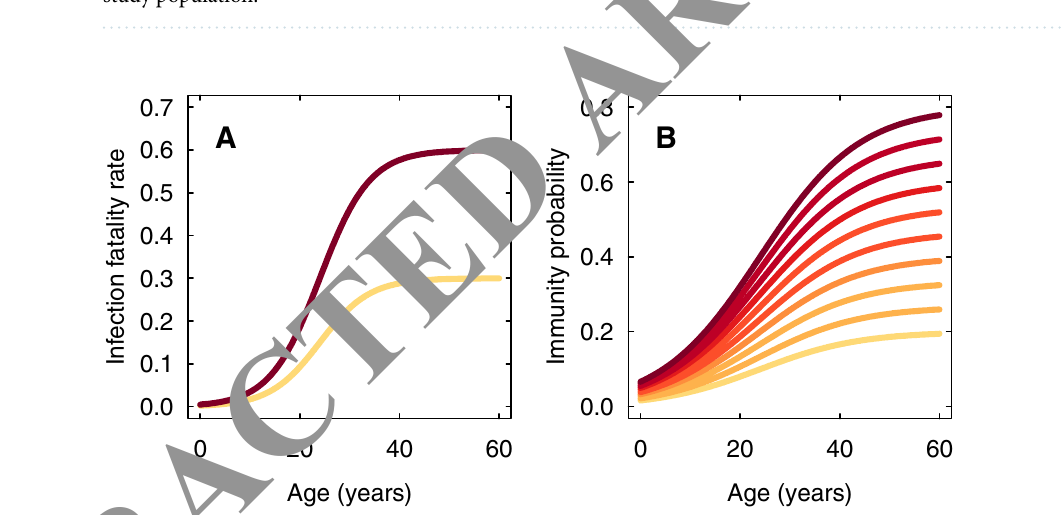
Figure 2. Age-specific infection fatality rate (IFR) ( A ) and immunity probability ( B ) used to model the potential impact of COVID-19 on the dynamics of the study population. The color gradient is only used to stress the gradual nature of the